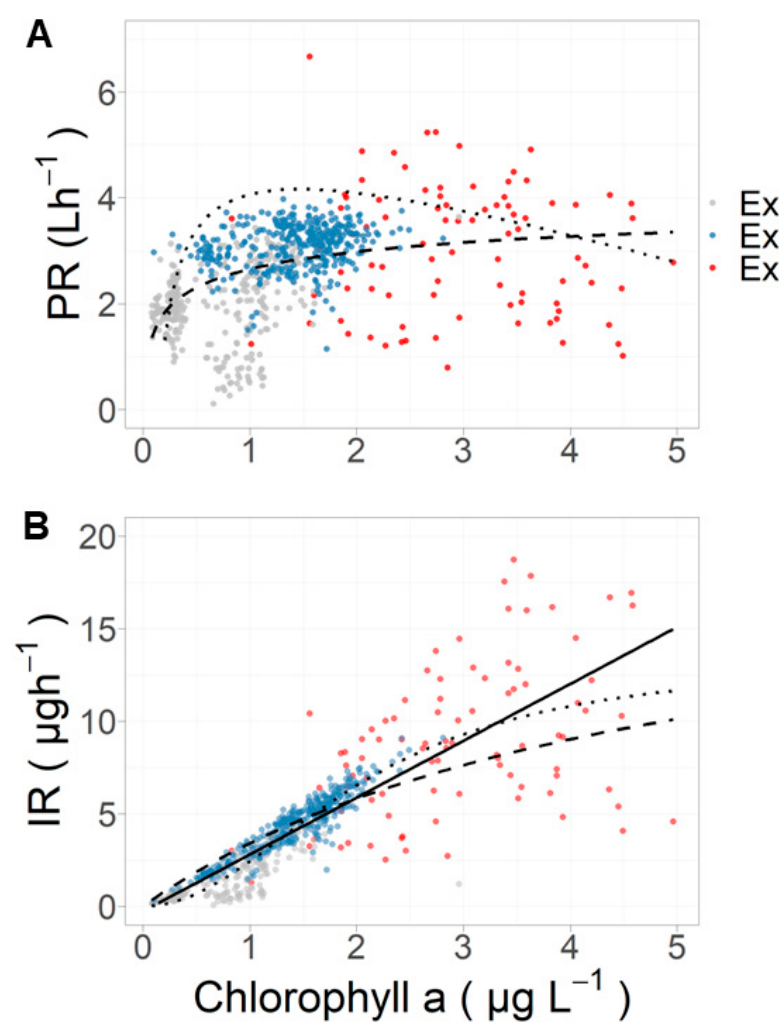
Figure 5. Relationships between ( A ) pumping rate (PR) (Lh − 1 ) and ( B ) ingestion rate (IR) ( µ gh − 1 ) and chlorophyll a ( µ gL − 1 ) for all experiments. The dotted line on ( A ) is drawn from Equation (5), and the dashed line is fitted from Equation (5) with parameters fit to this dataset: PR = 2.69 − 0.02 ( F ) + 0.53 ( ln ( F ) + 0.001/ F ) . The drawn lines on ( B ) represent Holling functional responses (Type I, II, and III, solid, dashed, and dotted, respectively) to indicate the potential relationships between flu- orescence and IR.